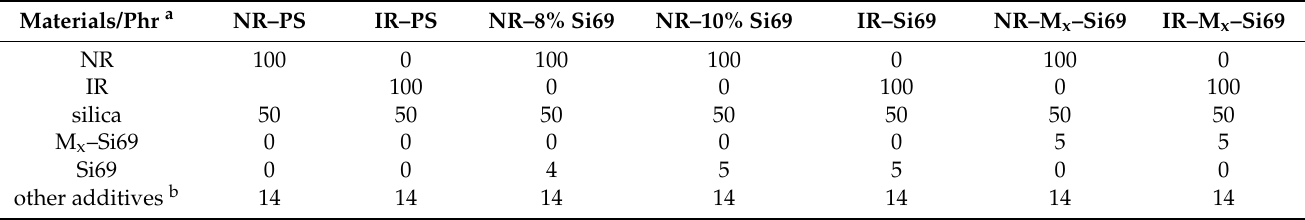
Table 1. Formulation of silica/rubber nanocomposites.